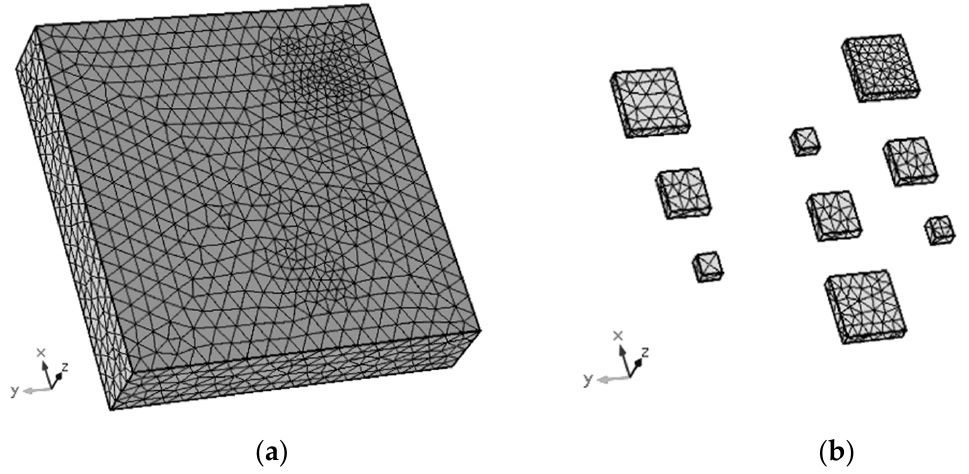
Figure 3. Geometry and mesh for: ( a ) Concrete sample; ( b ) simulated delaminations.